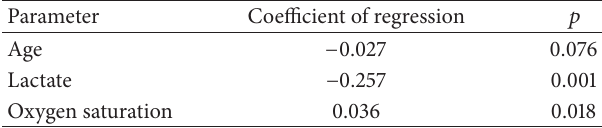
Table 5: Multiple regression on 30-day mortality ( 𝑛 = 211